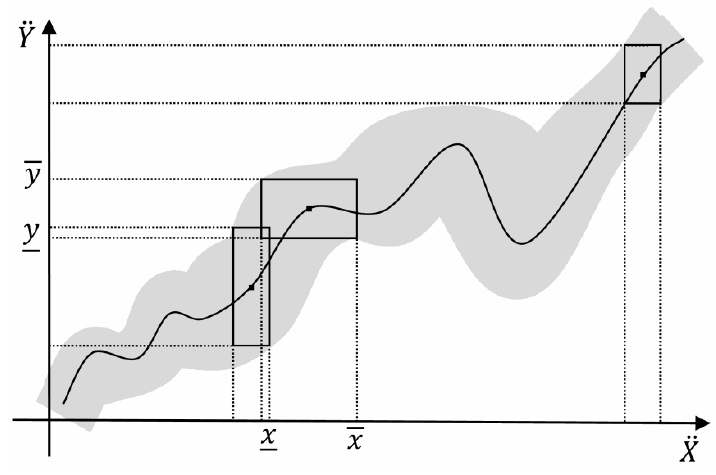
Figure 7. An exemplification of a system with single-valued and interval-valued